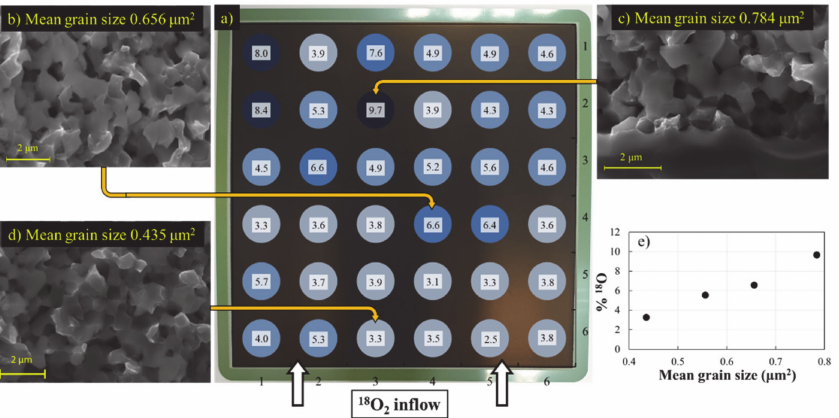
Figure 9. Composite figure of data gathered from long term SOFC test containing ( a ) the 18 O ratio map created from ToF-SIMS data from the active Ni-YSZ fuel electrode, ( b – d ) High resolution scanning electron microscopy pictures from near some more interesting sites with calculated mean Ni-YSZ grain sizes and ( e ) correlation between measured mean grain sizes and 18 O ratios at certain